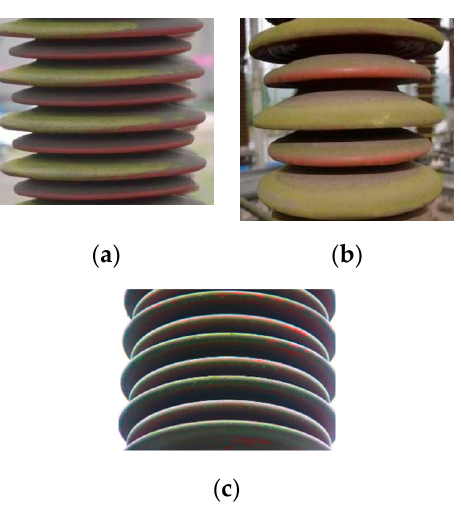
Figure 2. The algae contamination layer distribution. ( a ) GA JFS 110 kV pillar insulator. ( b ) YA CBS 110 kV pillar insulator. ( c ) NJ CSS 220kV circuit breaker pillar insulator.